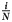
The X axis is the coefficient μ under different T, and the Y axis is the evolutionary stability strategy of iN.dx.doi.org/10.17504/protocols.io.bgbgjsjw.